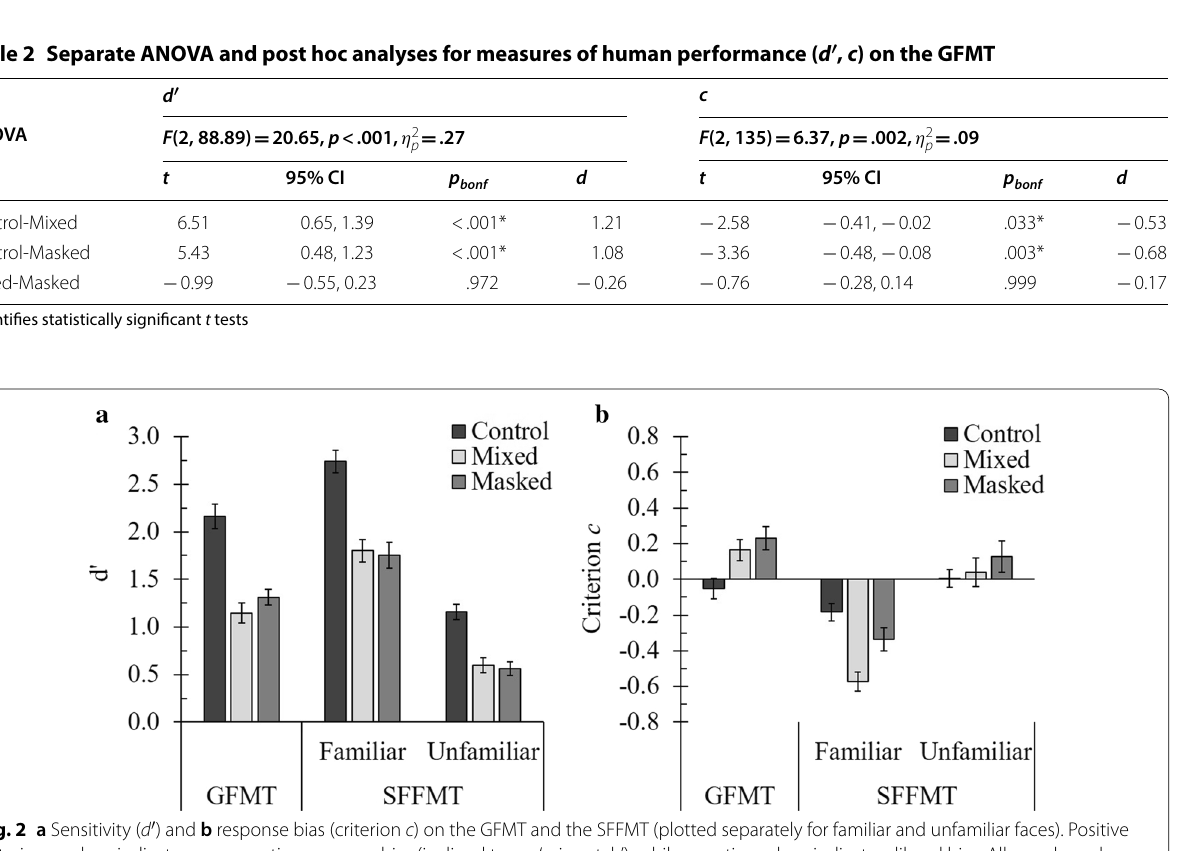
Fig. 2 a Sensitivity ( d ′ ) and b response bias (criterion c ) on the GFMT and the SFFMT (plotted separately for familiar and unfamiliar faces). Positive criterion c values indicate a conservative response bias (inclined to say ‘mismatch’), while negative values indicate a liberal bias. All error bars show the standard error of the mean